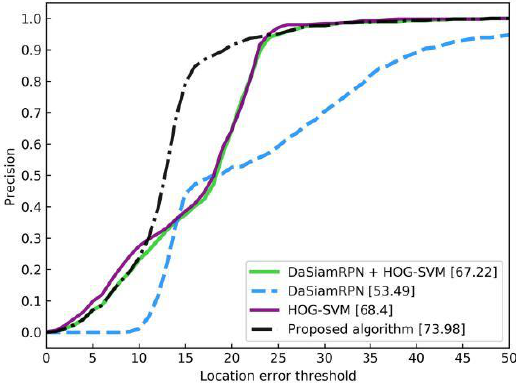
Figure 12. The precision plots of Video Sequence I.